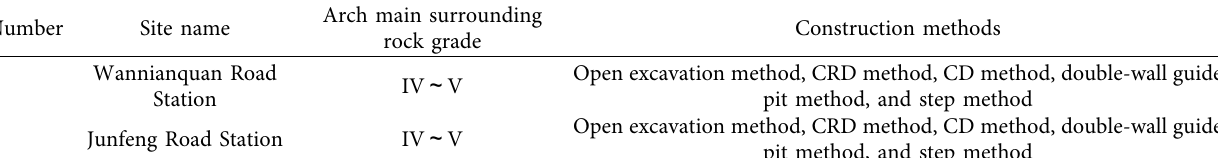
Table 3: Main construction methods of underground excavation station of Subway Line 3.